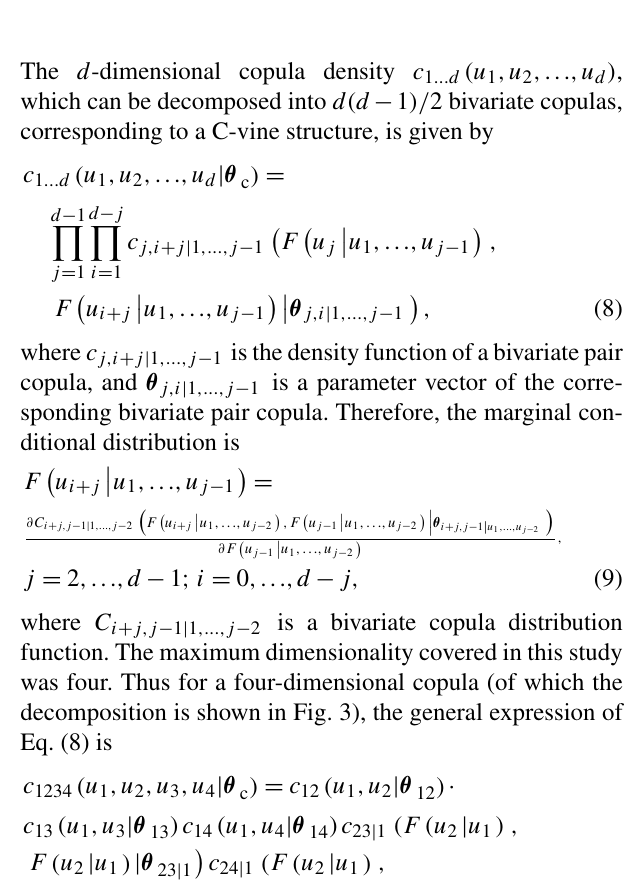
Figure 2. Relationship in Eq. (2). (a) The contour plot of the RRCI against both the RI and the OR-JEP; panel (b) is the function curves of the RRCI against the OR-JEP under different values of